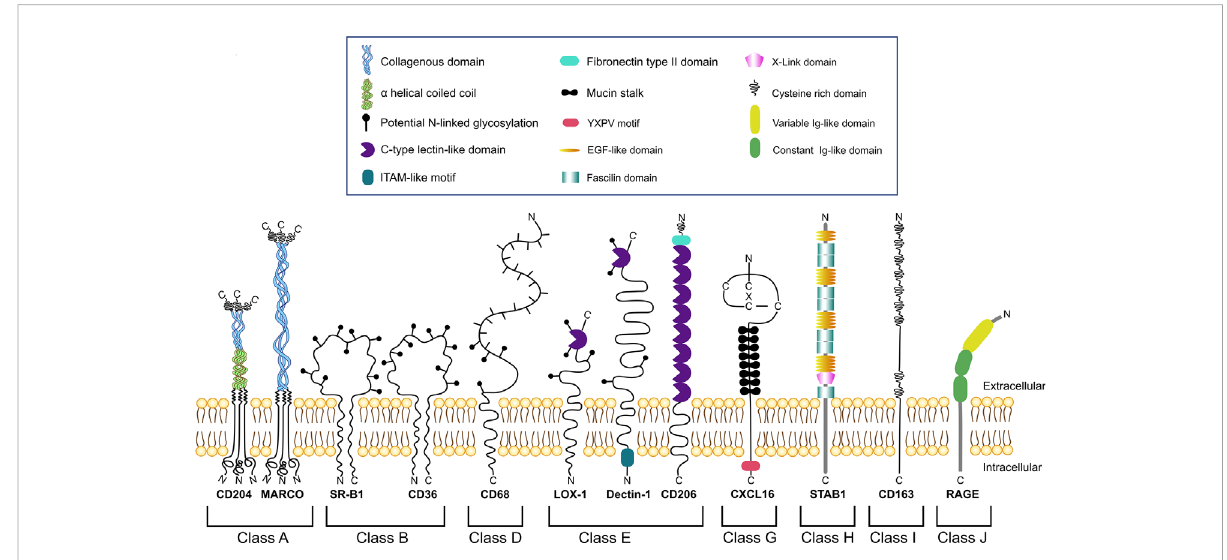
FIGURE 1 Schematic representation of different classes of scavenger receptors expressed by